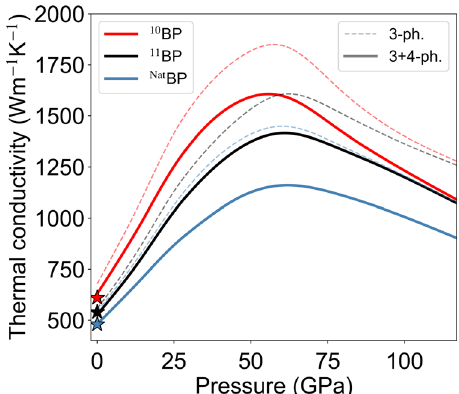
Fig. 1 Pressure-dependent thermal conductivity of BP. Room temperature thermal conductivity of BP with naturally occurring B isotope concentration (blue), isotopically pure 11 B (black), and isotopically pure 10 B (red) as a function of hydrostatic pressure, P , with (solid) and without (dashed) four- phonon scattering. With increasing P , all curves show a sharp rise followed by a peak and subsequent drop, contrary to behavior in many other materials. Stars indicate measured values at ambient conditions 33,34